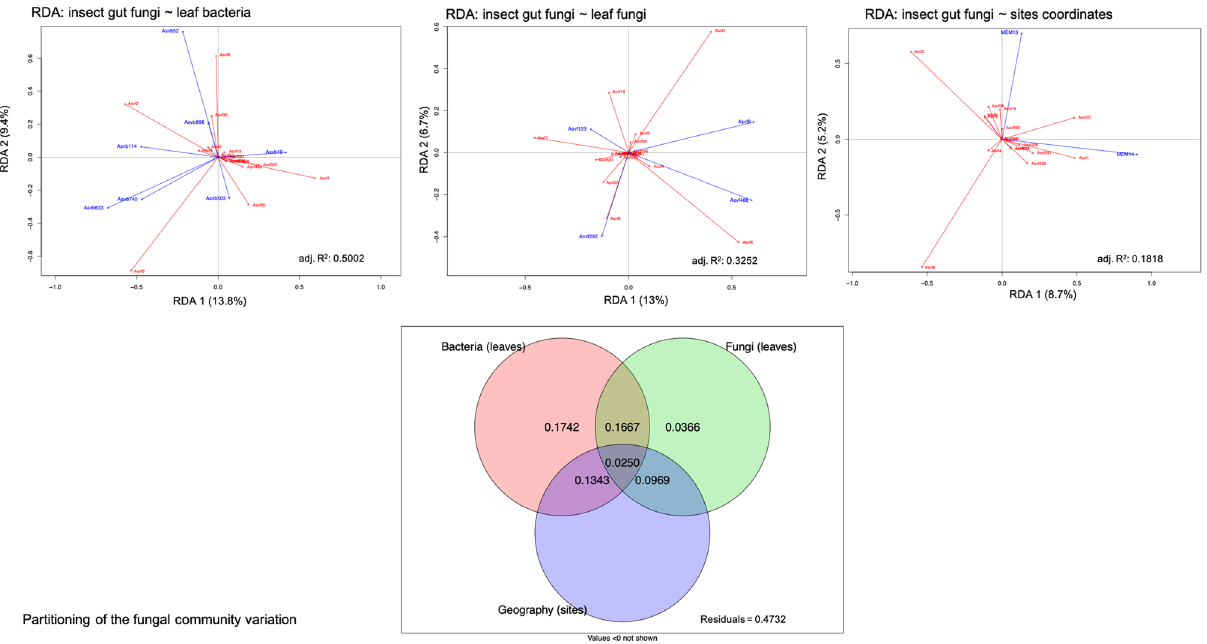
Figure 5. Variation partitioning of the gut fungal community among three predictor matrices: bacteria associated with leaves (Hellinger-transformed), fungi associated with leaves (Hellinger-transformed), and dbMEM spatial eigenfunctions generated from the geographic coordinates of the sampling sites ( Fraxinus trees). The selected explanatory variables (leaves) are represented in blue, and the response variables (insects’ gut) in red. Thus, the three explanatory matrices (bacteria, fungi, and geographic coordinates) are represented in individual RDA analyses. The adjusted R-square (adj.R 2 ) corresponds to the R 2 adjusted to the model containing all variables. The figure below the RDAs represents the partitioning variation analyses of the fungal community associated with adult EAB regular trap monitoring. Based on previous observations on adult flight activity and the calculation method of degree-days 11 , traps were deployed and monitored after a period of 341.7 degree-days (base 10 °C) was reached. Adults were collected twice weekly in 2018, from June 21st to August 3rd. For each selected tree and each sam- pling date, insects were transferred into a disinfected plastic container using sterilized tweezers and supplied with fresh ash tree leaves as substrate and food source. Containers were kept on ice during transport to the laboratory. Each healthy insect was immediately transferred into labelled sterile 1.5 mL microfuge tubes, frozen at − 80 °C, and stored until DNA extraction. The number of insects collected per tree ranged from two to 100 EAB adults. Leaf sampling. For each selected tree, for each selected tree, several leaves surrounding the trap were collected using a 10-m aluminium extendable pole tree pruner. Separate samples were placed in sterile bags and trans- ported on ice to the laboratory at the fourth sampling week. Subsamples of each tree corresponding to five leaves randomly selected were then stored at − 80 °C before DNA and metabolite extractions. Until digitalization, foliar voucher samples are available to Guertin’s laboratory for further consultation. Several site locations were visited to collect leaf samples and deployed traps to catch insects. For each place where plants and EAB adults have been collected, we obtain the authorization of private landowners and munici- palities before collecting and using them in this study.